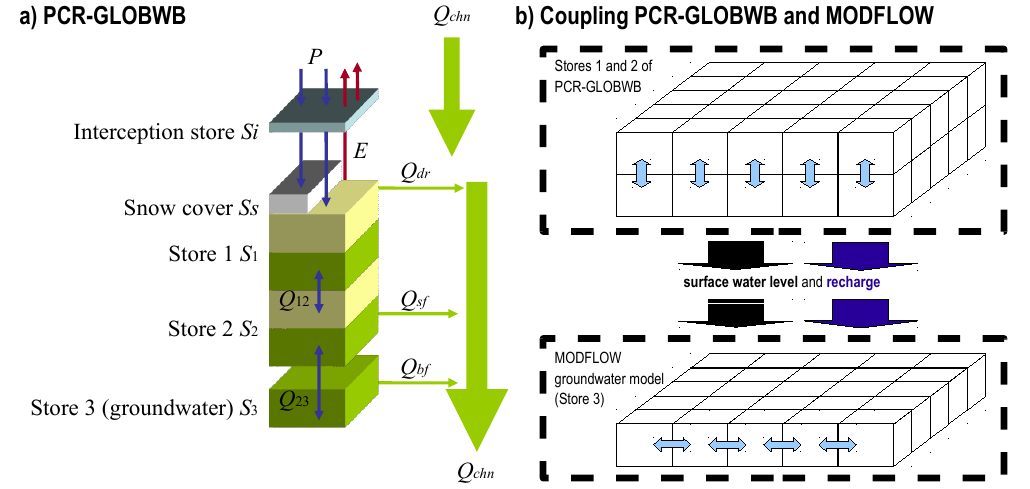
Fig. 2. The modeling structure and strategy for this study: (a) the concept of the land surface model of PCR-GLOBWB (Van Beek and Bierkens, 2009; Van Beek et al., 2011): on the left, the soil compartment, divided in the two upper soil stores, S 1 and S 2 , and the linear groundwater store, S 3 , that is replaced by the MODFLOW (McDonald and Harbaugh, 1988) groundwater model; on the right, the total local gains from all cells are routed along the local drainage direction to yield the channel discharge, Q chn . (b) The modeling strategy used to couple the PCR-GLOBWB and MODFLOW: first, we run the PCR-GLOBWB to calculate the monthly net recharge Q 23 to groundwater store and channel discharge Q chn that can be translated into surface water levels by assuming channel dimensions. Then, the monthly net recharge and surface water levels are used to force